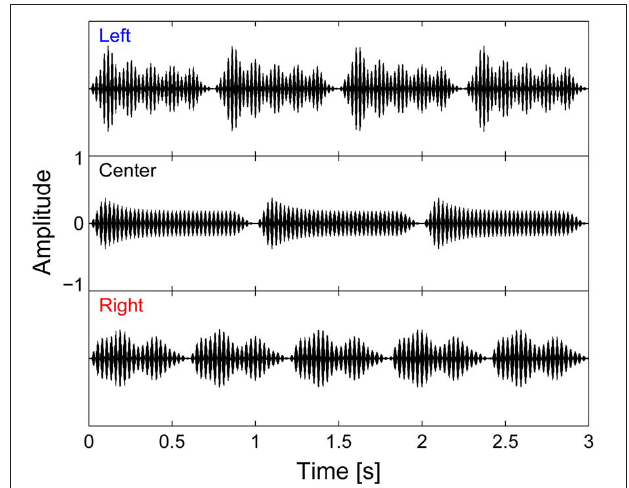
FIGURE 1 | Auditory stimuli waveforms. Left, center, and right auditory streams are each isochronous, and made up of four, three, and five notes, respectively. All streams have a total duration of 3s; however, except for the first note, the streams were designed to have note onsets that are temporally resolvable across streams note onsets are